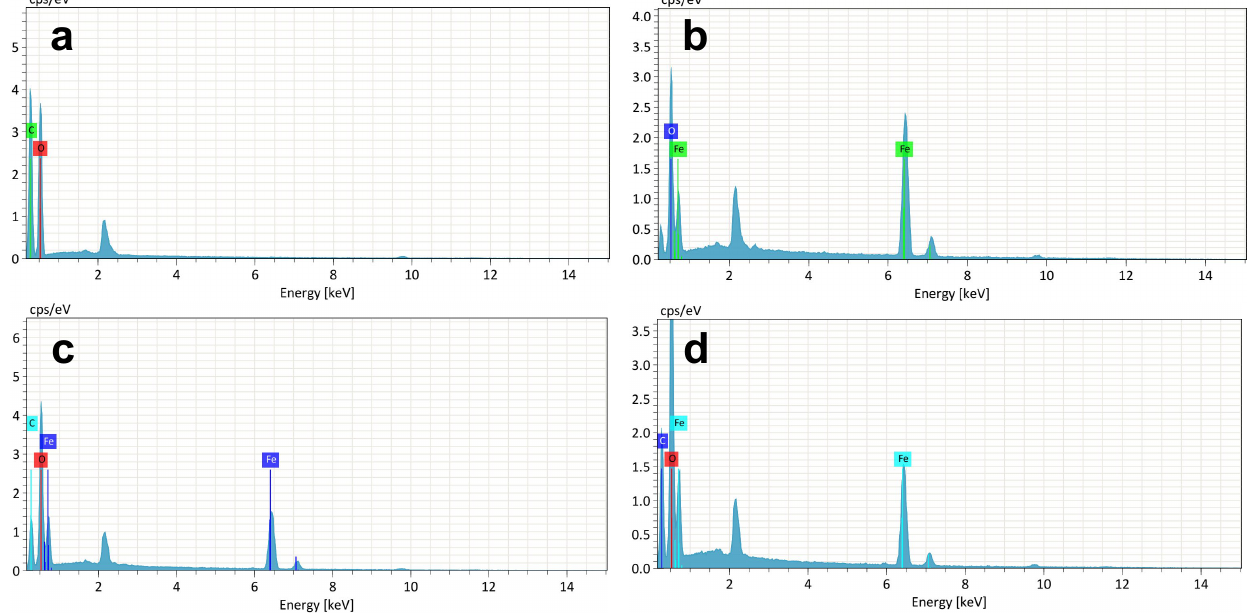
Figure 7. EDS spectrum of ( a ) cellulose, ( b ) MIO-NPs, ( c ) SCB/MIO-NCPs, and ( d ) WTP/MIO- NCPs.